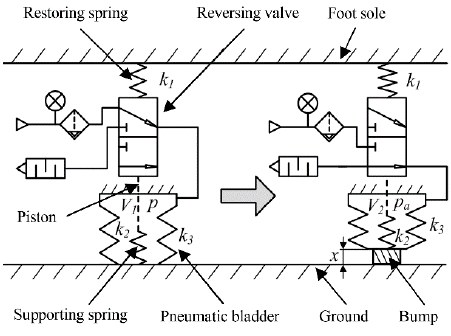
Figure 3. Working principle diagram of the pneumatic variable stiffness unit (PVSU).